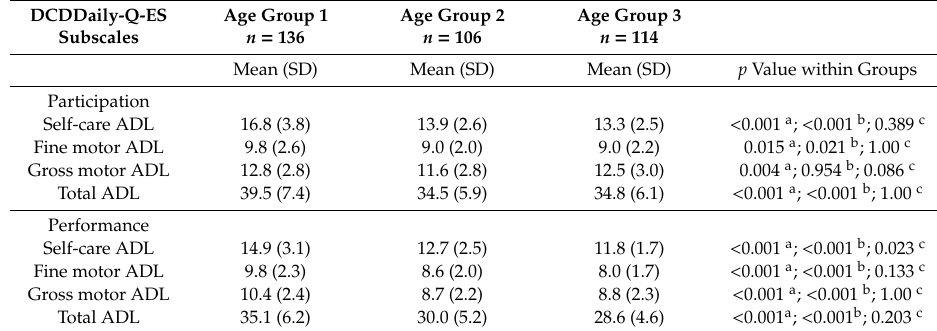
Table 2. Di ff erences in DCDDaily-Q-ES subscales and total scores for participation and performance in activities of daily living (ADL) across age groups ( n =